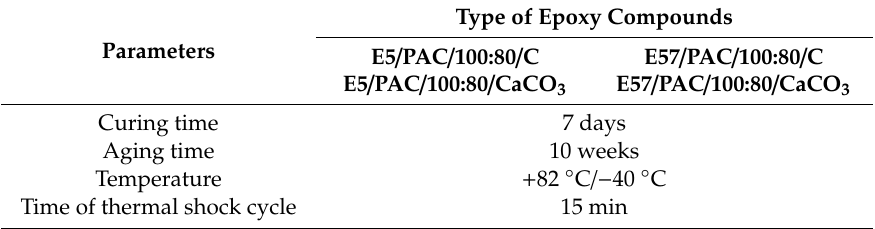
Table 5. Aging conditions of the epoxy specimens in the thermal shock